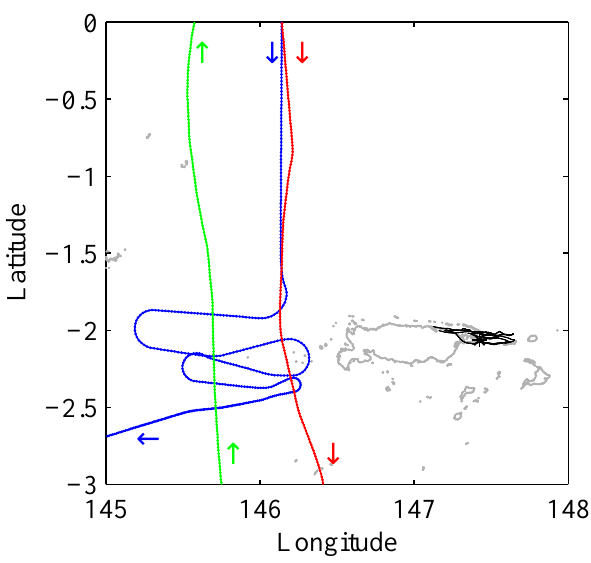
Figure 3. Map of the co-located measurements of Gulfstream V flights RF09 and RF14, and CAST ozonesondes 6, 34 and 35. The blue flight path is RF09, the red is the outbound leg of RF14 and green is the return leg of RF14. The black lines are the flight paths of ozonesondes 6, 34 and 35, which all remained in the east of Manus Island at all times. The arrows show the direction of travel of the Gulfstream V.